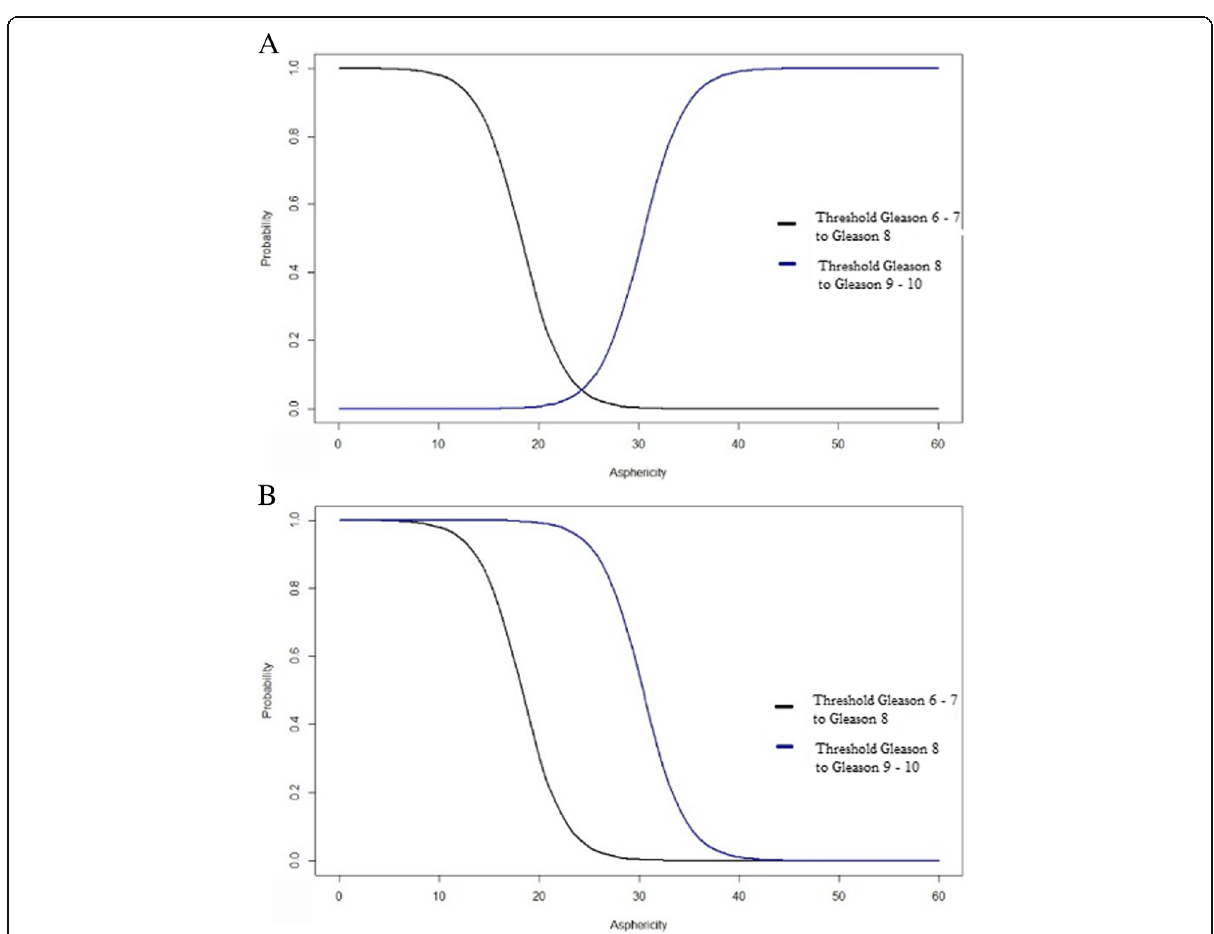
Fig. 4 Probabilities of a Gleason score for different asphericity values. a The chart plot demonstrates the relative probability for the differentiation between prostate cancer lesions with Gleason score 6 – 7 and 8 as well as Gleason score 8 and 9 – 10. The area left of the black curve indicates the probability of Gleason 6 – 7, the area between black and blue curves indicate the probability of an ASP being scored Gleason 8 and the area to the right of the blue curve indicate the probability for Gleason 9 – 10. b The lower chart demonstrates cumulative probabilities of a Gleason score subgroup based on an ASP value containing the same areas beside the curves as described